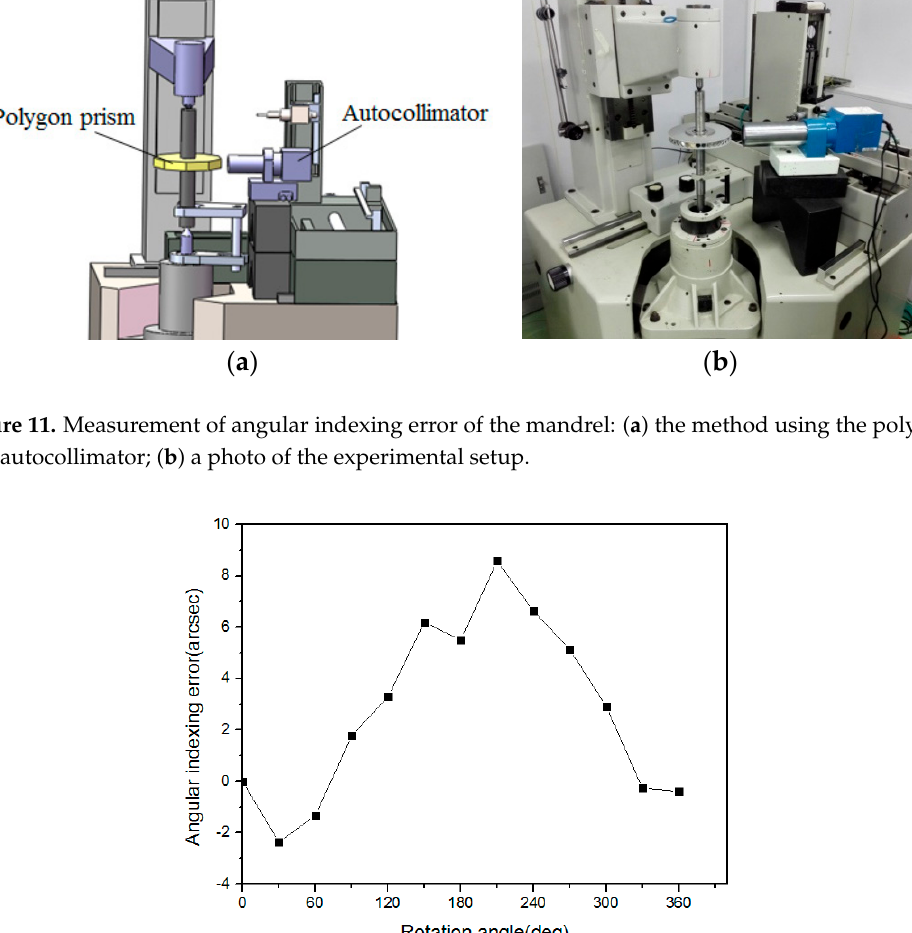
Figure 13. Repeatability plot of angular indexing error of the mandrel after a 90° shift.